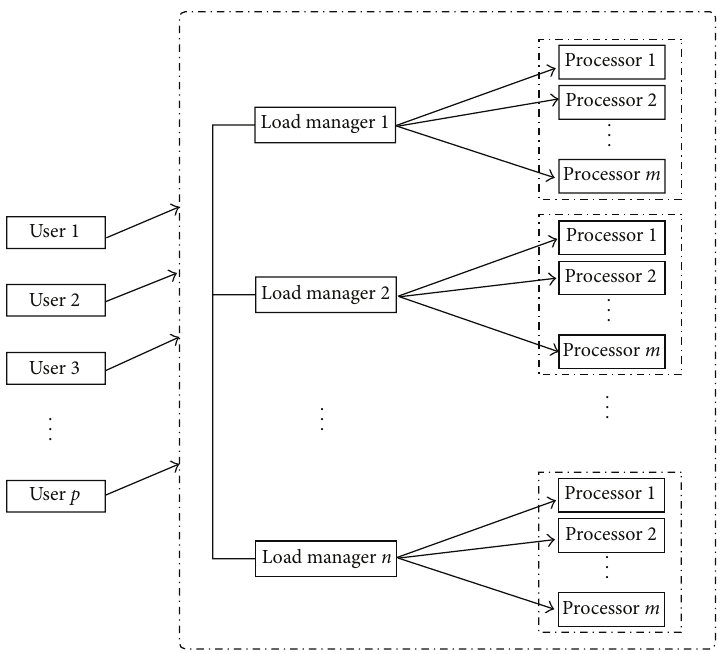
Figure 2: Load balancing model for future